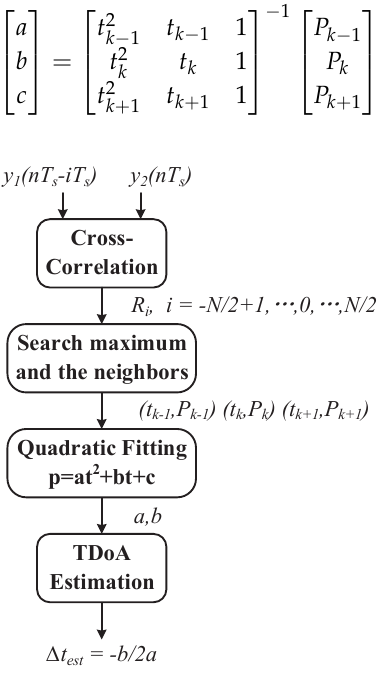
Figure 3. TDoA estimation based on cross-correlation calculation and quadratic